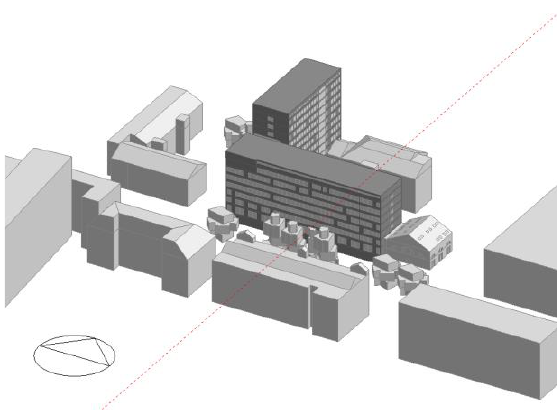
Figure 1. Visualization of the model of the building and its surroundings. 98